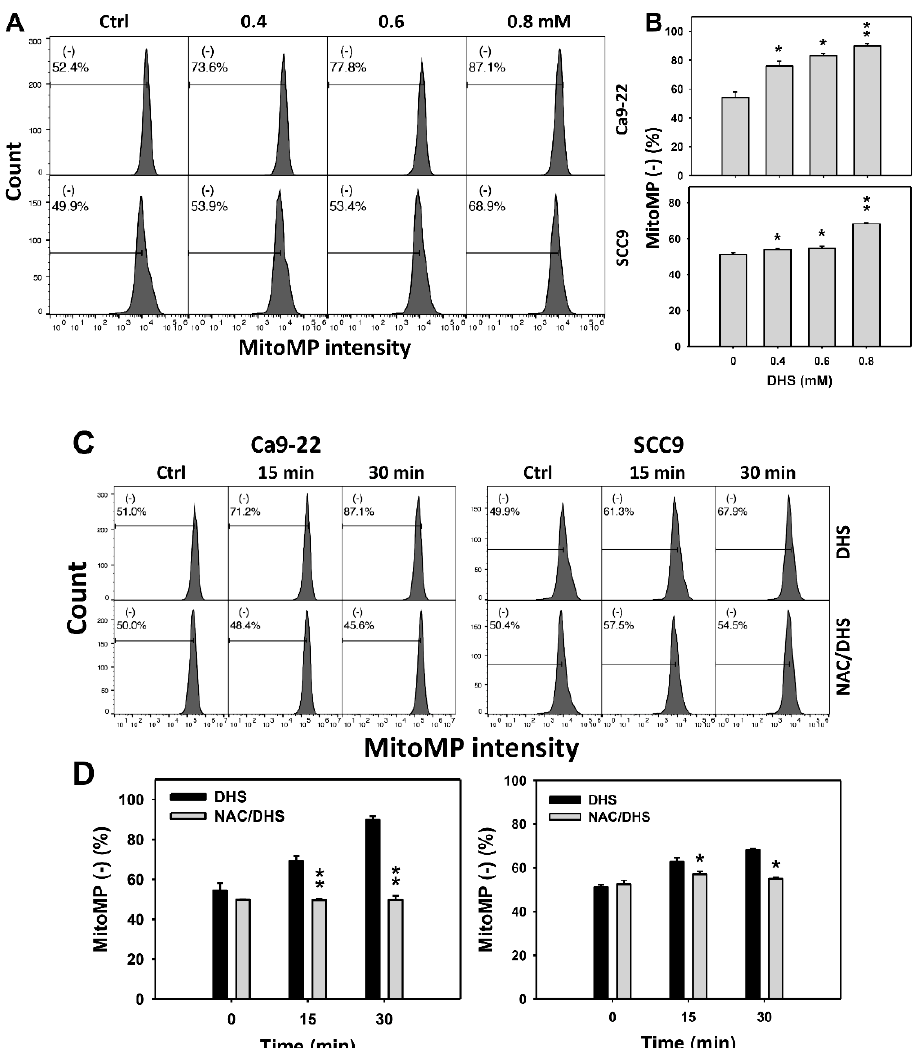
Figure 7. DHS effects on MitoMP contents of oral cancer cells. ( A , B ) Representative MitoMP patterns of DHS-treated oral cancer cells. Cells (Ca9-22 and SCC-9) were treated with 0.4, 0.6 and 0.8 mM DHS or vehicle (containing 0.08% DMSO) for 48 h. ( − ) indicates the low MitoMP populations. ( C , D ) Alleviation of the MitoMP changes of DHS-treated oral cancer cells by NAC. Cells were pretreated with NAC (10 mM, 1 h) or not, and then they were treated with 0.6 mM DHS or vehicle for 0, 36 and 48 h. Data = means ± SDs ( n = 3 independent experiments). * and ** indicate significant differences between ( A , B ) DHS and control and ( C , D ) DHS and NAC/DHS ( p < 0.05 and 0.01, respectively). A positive control for MitoMP depletion of oral cancer cells is provided in Supplementary Figure